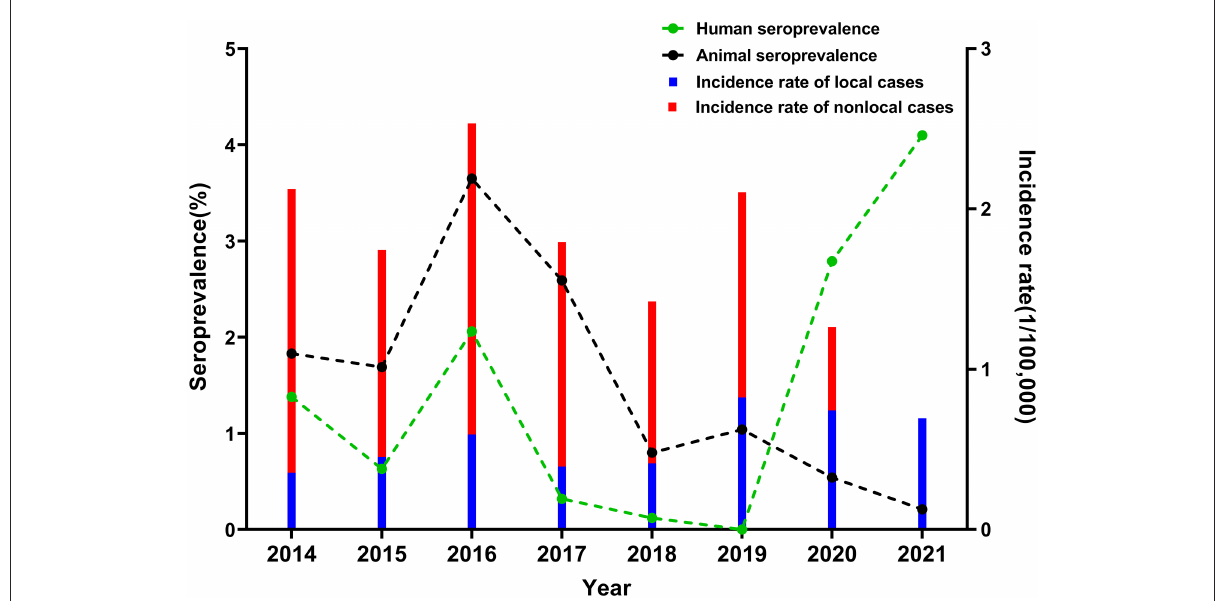
FIGURE3 Seroprevalence of brucellosis in human and animals in Xi’an, 2014–2021. Blue and red bar charts represent the annual incidence of local and non-local cases, respectively. Green and black lines represent the annual seroprevalence of human and animals,